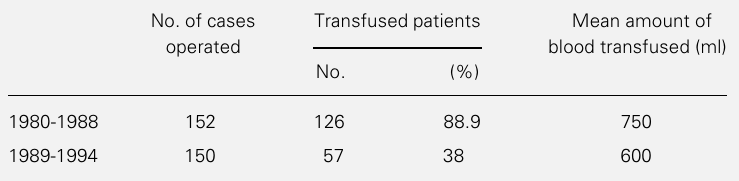
Table 1 - Radical hysterectomy patients who required blood transfusion. No. of